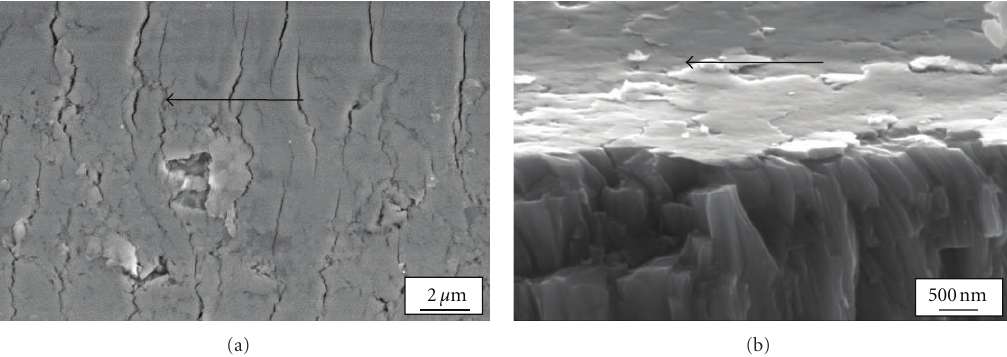
Figure 9: Wear mechanisms observed in the multi-pass scratch test. (a) Chipping of fine coating fragments in connection to transverse cracking and (b) delamination of thin plate-like fragments (fractured cross section) originating from a thin tribo film for Ti 0 . 34 Al 0 . 66 N coating. The arrows indicate the scratching direction.